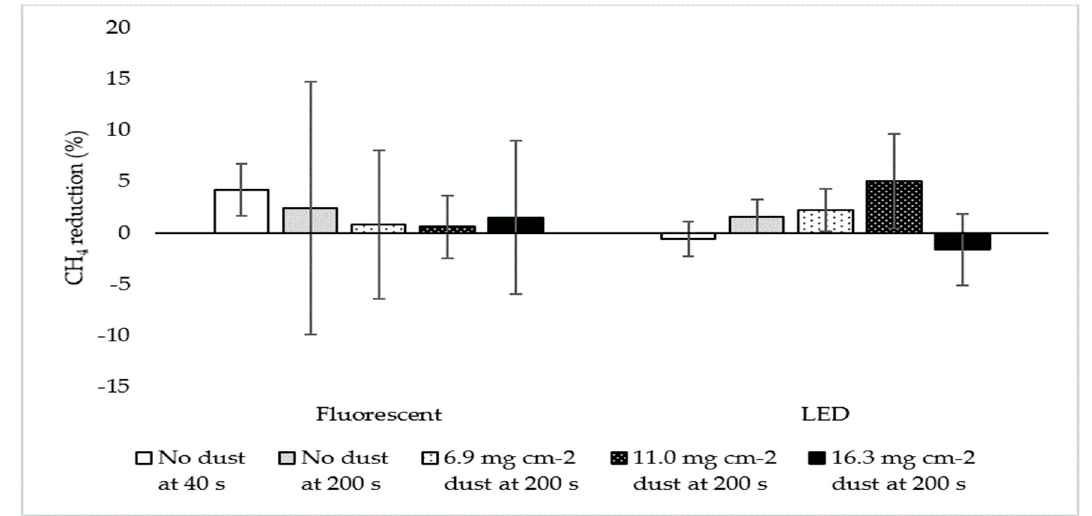
Figure 9. CH 4 mitigation under di ff erent poultry dust levels at 12% relative humidity in photocatalysis. Error bars signify ± standard deviation.